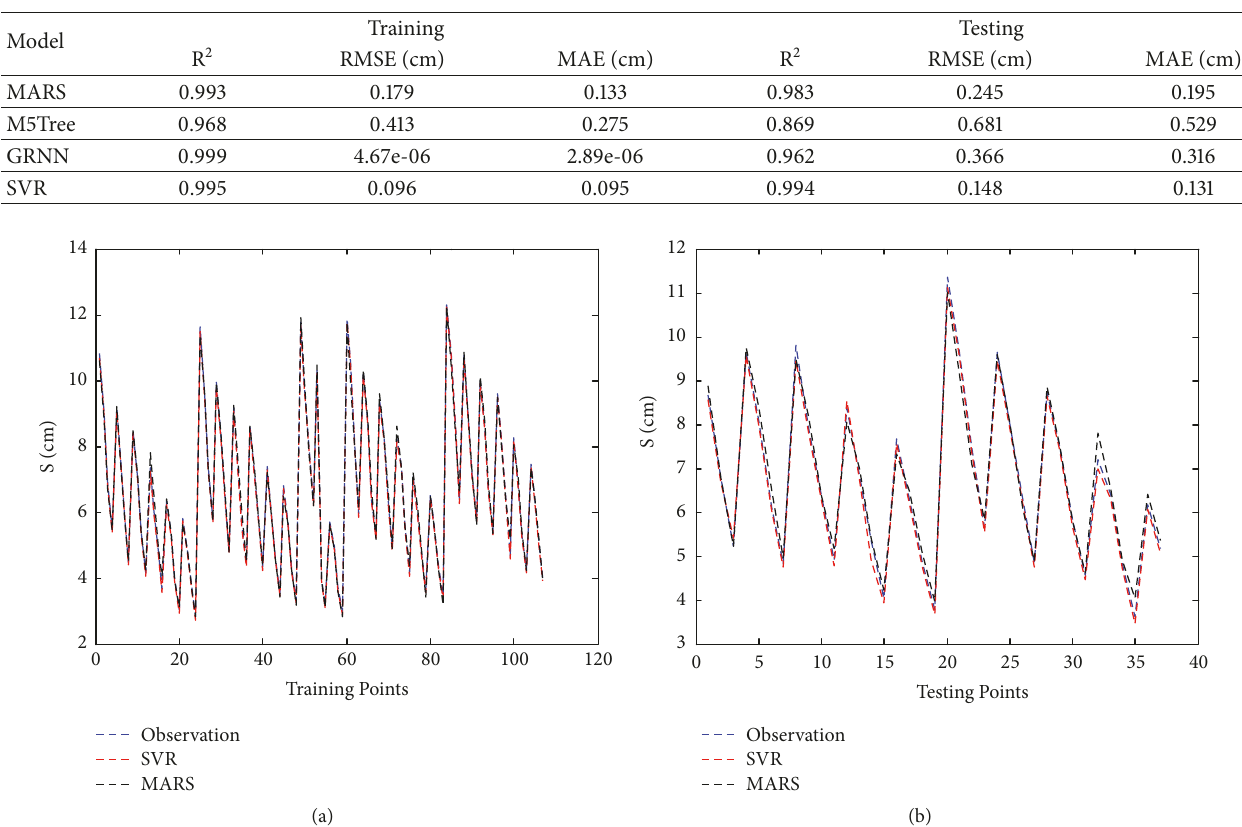
Table 5: Statistical performance of the designed settlement prediction models.